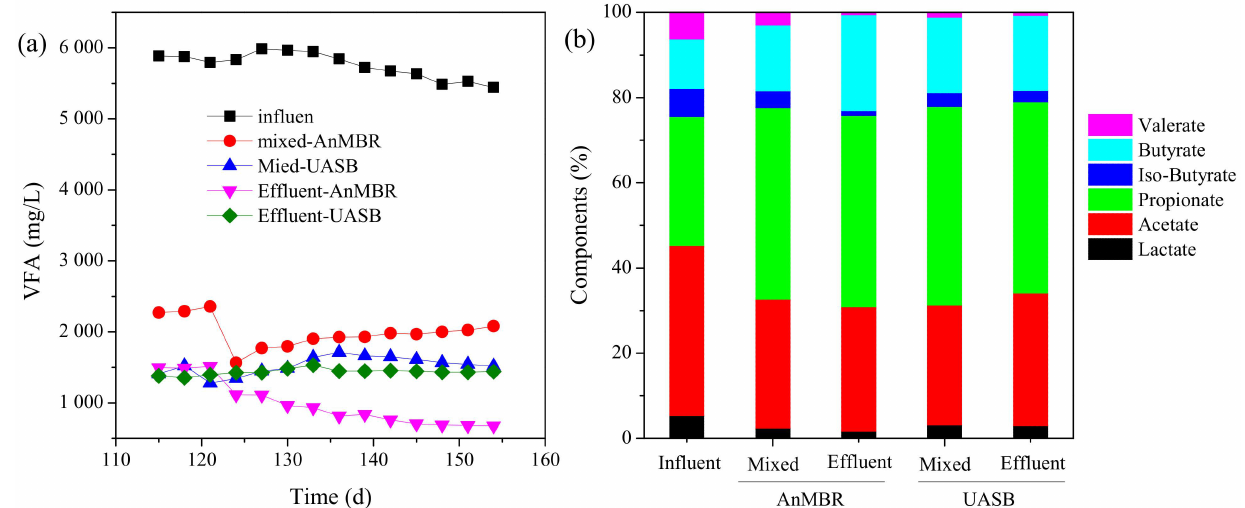
Figure 3. Variations in the content ( a ) and composition ( b ) of VFAs in the two studied